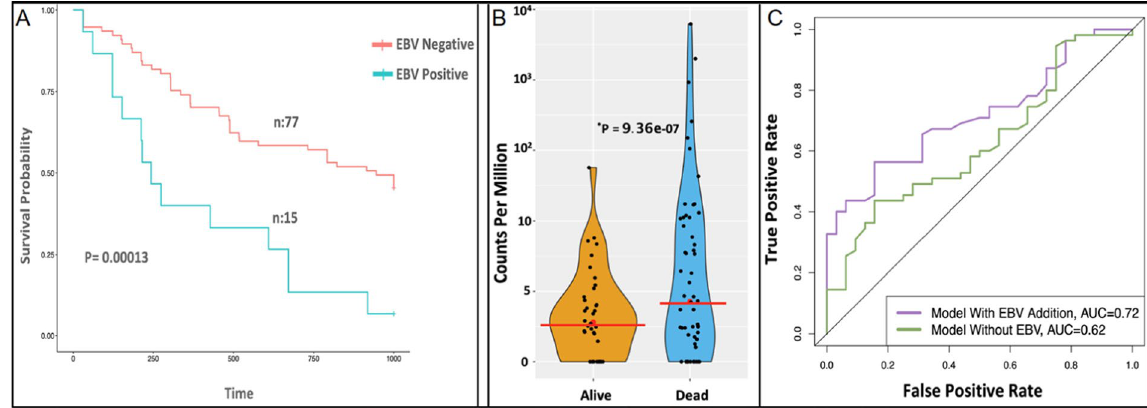
Figure 3. Survival analysis and prognostic model for EBV status in adult AML. ( A ) Kaplan-Meier curve compared the survival of EBV positive (blue) versus negative (red) AML patients in 1000 day survival analysis which significantly differed (P < 0.00013). ( B ) The difference in total miRNA EBV levels was remarkable when comparing patients who survived or died with only one survivor greater than 10 1 CPM (wilcoxon rank test P-value = 9.3 × 10 − 07 ). ( C ) Area under the curve (AUC) based on cutoffs for the multivariate Cox